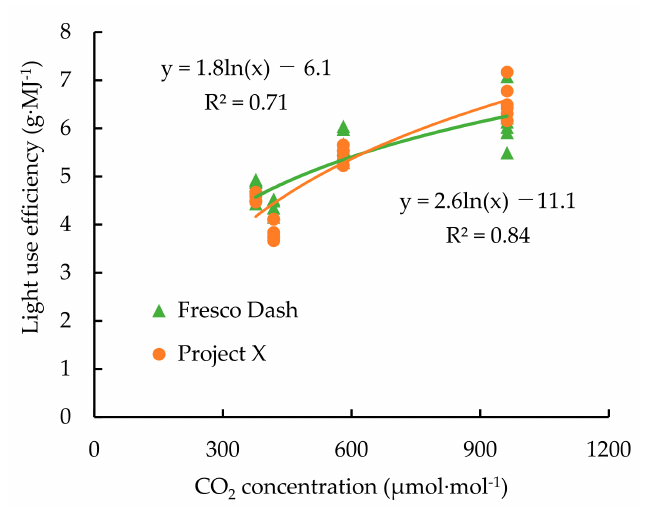
Figure 4. Observed light-use efficiency (g MJ − 1 , where MJ is a unit of photosynthetically active radiation) of two cultivars as a function of the average daytime CO 2 concentration in cucumber plants. ( R 2 = 0.71 for “Fresco-dash”, R 2 = 0.84 for “Project X”; p < 0.001; n = 24). From the destructive measurements, the fractions of DMD to fruit did not differ between the two cultivars (FD: 46.0%, PX: 45.2%). There were no significant differences in DMCs between the two cultivars (FD: 3.84%, PX: 3.78; data not shown). In the model validation experiment, the average daytime CO 2 concentrations were approximately 550 (10 September to 10 November), 800 (11 November to 10 March), and 600 (11 March to 31 March) µ mol · mol − 1 (Figure 1B). The daily average